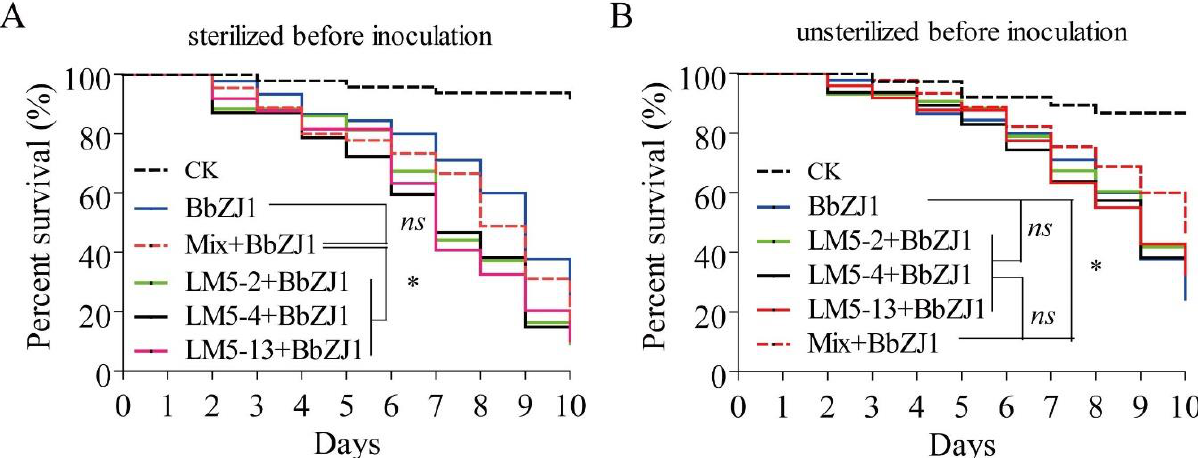
Figure 3. Effect of interaction between surface symbiotic bacteria and Beauveria bassiana on virulence of B. bassiana against Locusta migratoria . ( A ) Survival curves of L. migratoria that were surface-sterilized before inoculation with B. bassiana and bacteria. ( B ) Survival curves of locusts with unsterilized surfaces before inoculation with B. bassiana and bacteria. Mix: inoculation of a mixture of three bacteria strains. CK: treated with 0.05% Tween-80. The log-rank (Mantel – Cox) test method in GraphPad 5 software was used to analyze the differences among the survival curves. “*” Significantly different at 0.05 level. “ ns ” Not significant different at 0.05 level.